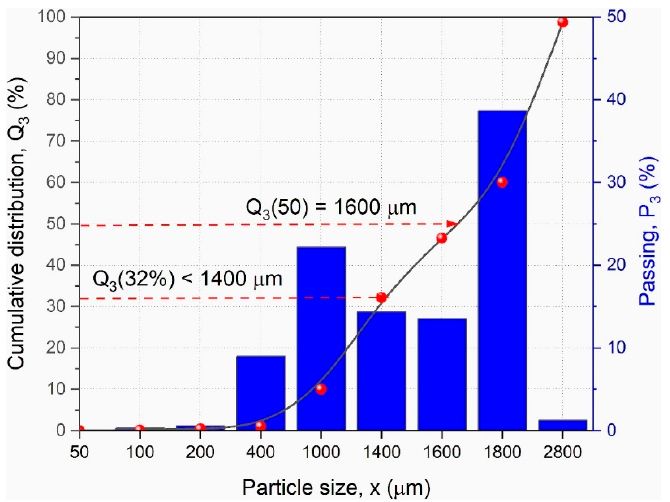
Figure 2. Cumulative distribution curve of the fractions (Q3) and percentages of the fractions (P3) of the ASR mixture used in this study.